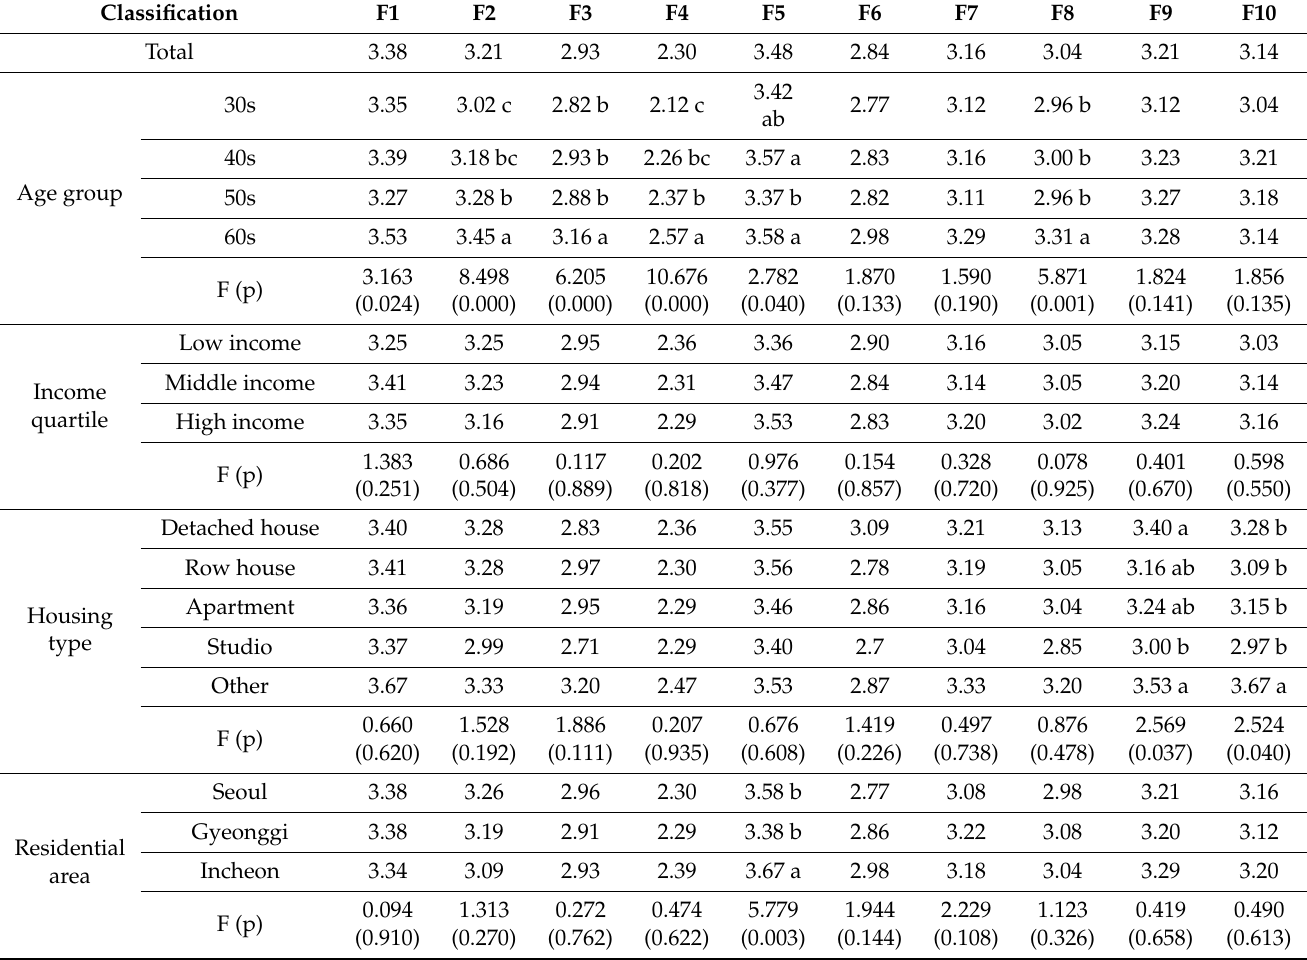
Table 8. Demographic characteristics of perceived problems caused by street